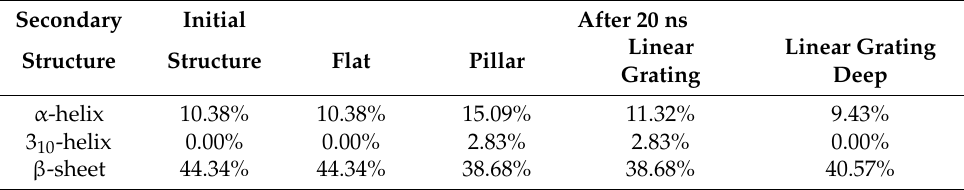
Table 1. Initial and final BMP-2 secondary